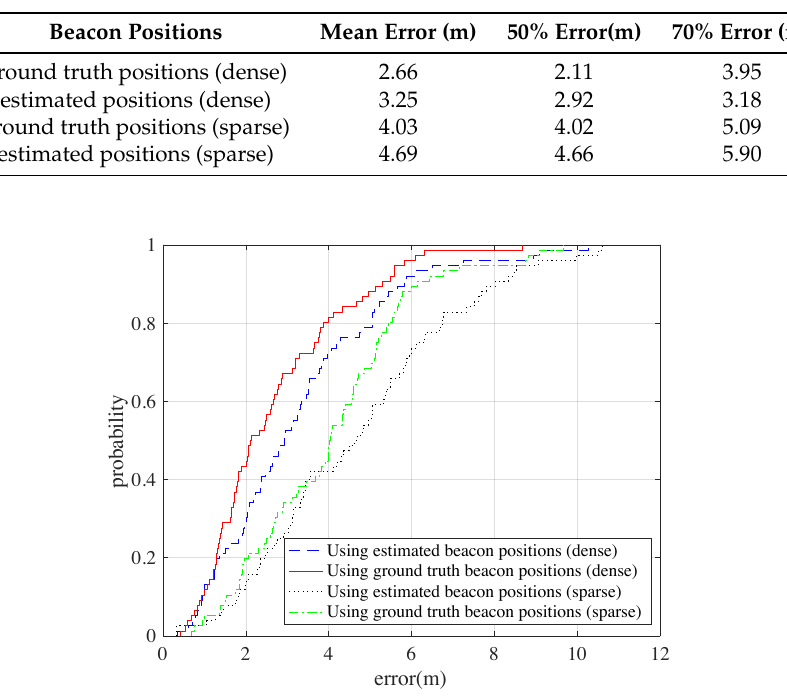
Figure 10. The CDFs of positioning errors using the ground truth beacons positions and the estimated beacon